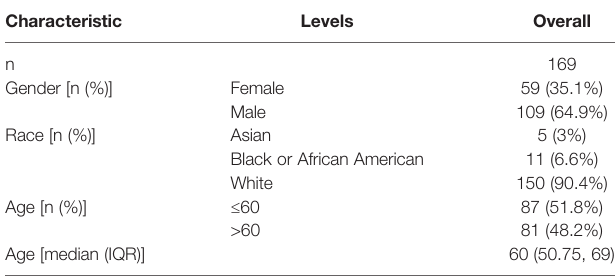
TABLE 1 | Clinical characteristics of the GBM patients used in the derivation cohort.